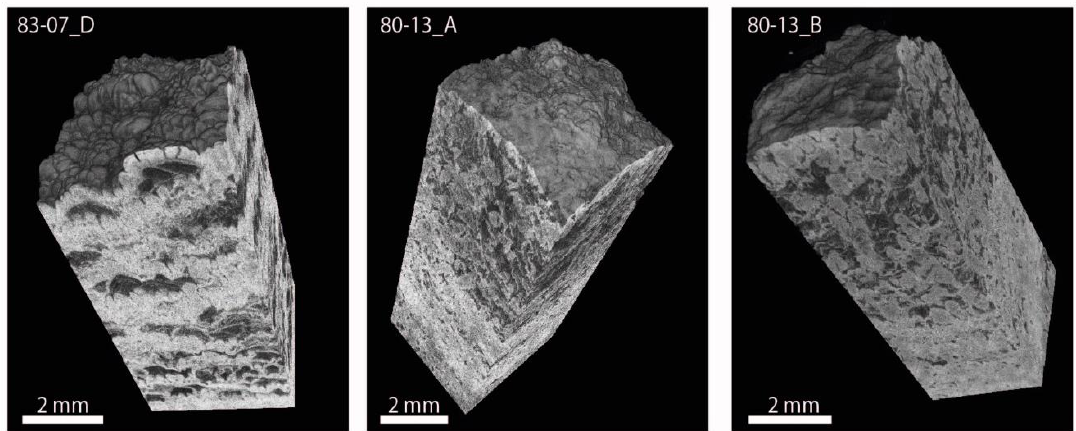
Figure 8. Block diagrams of the three samples drilled parallel to the growth direction and imaging a top surface. The growth surface in 83-07 D is clearly different from the rougher and more mottled surfaces in both the samples drilled from 80-13. In 83-07, the small botryoids can be seen to connect to pillar growths beneath them, while in the 80-13 samples, the surface cross cuts any subsurface structure, suggesting that it is erosional.